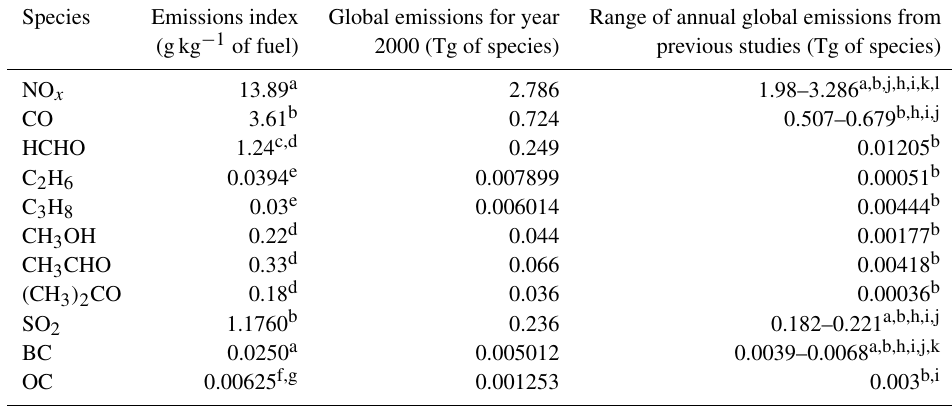
Table 1. Aviation emissions indices and total annual emissions for year 2000.